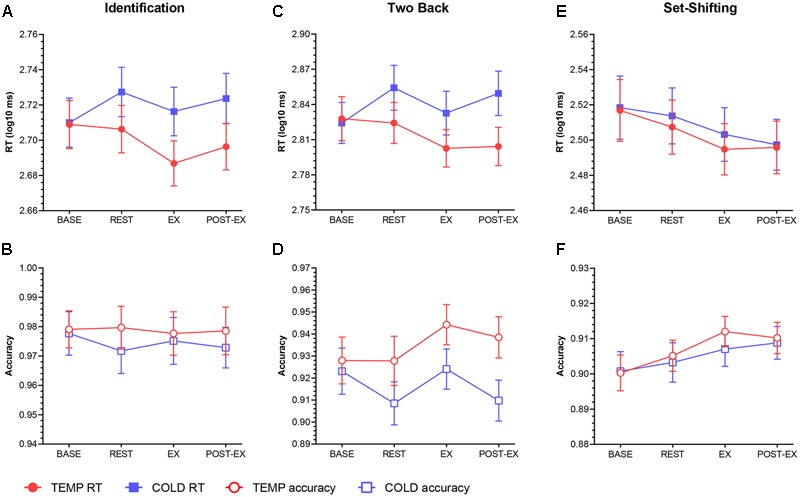
Mean RT and accuracy data for Identification (A,B), Two back (C,D) and Set-shifting (E,F) tasks. Error bars represent SEM.